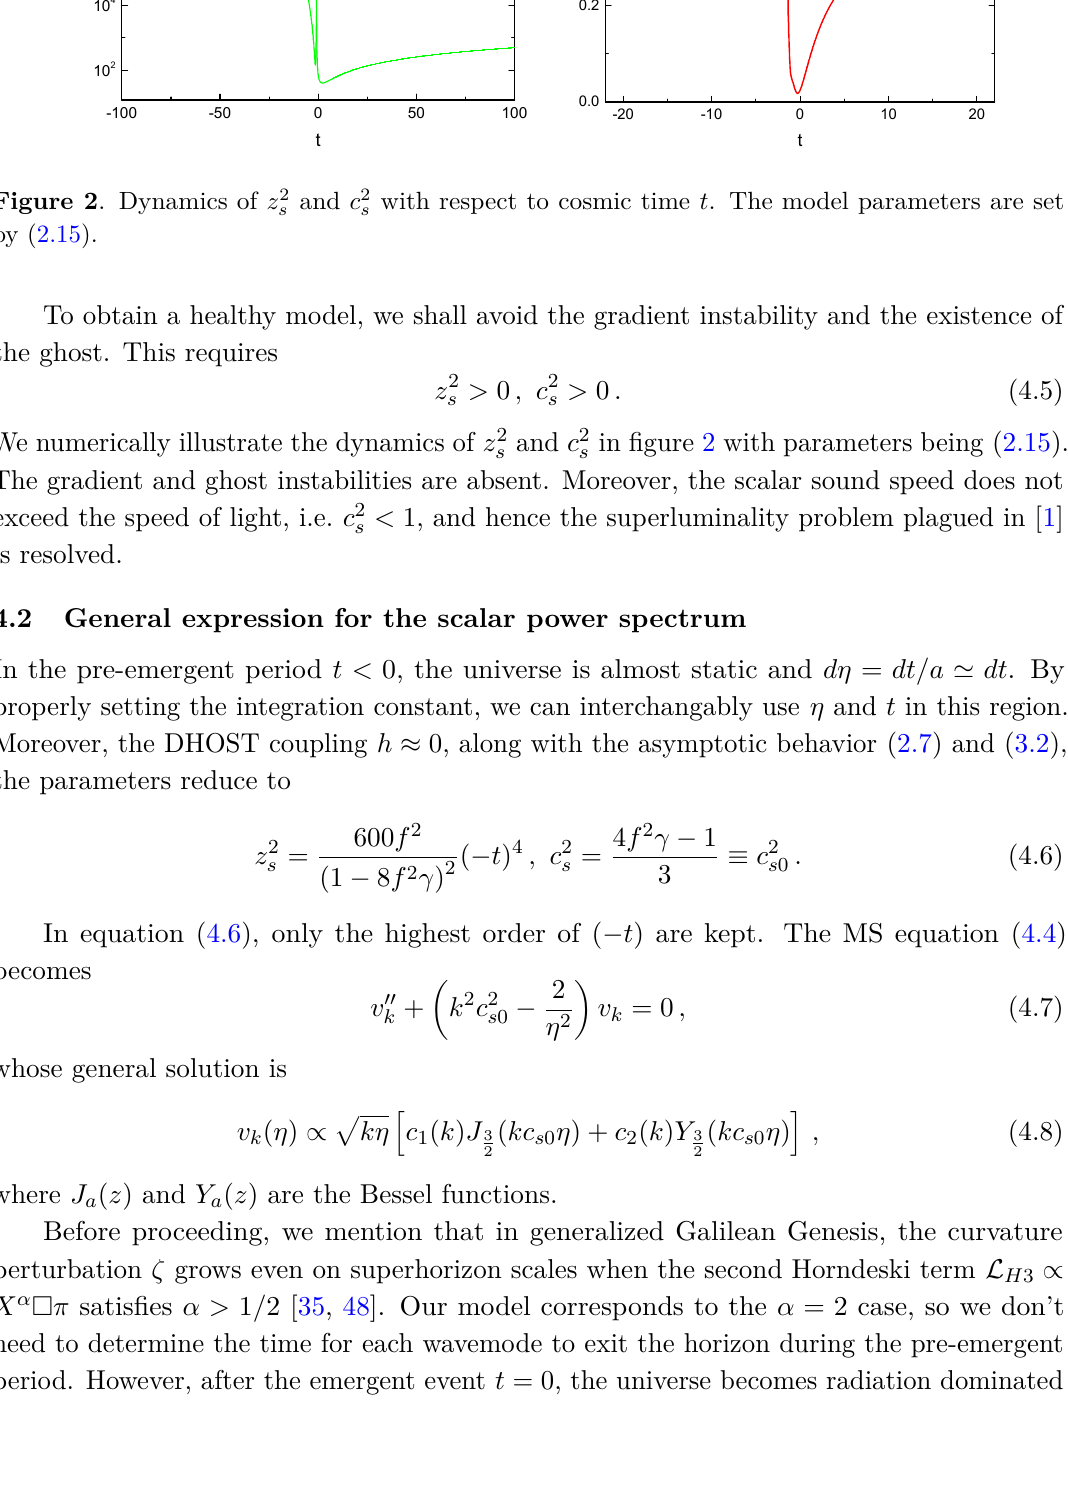
and c 2 with respect to cosmic time t . The model parameters are set s s